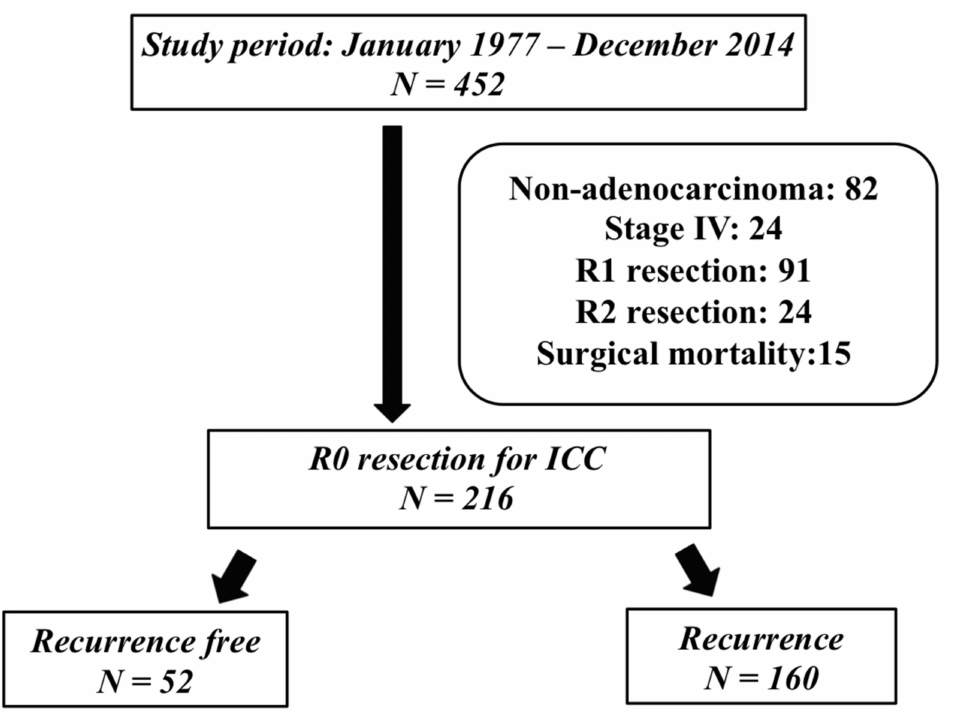
Figure 1. The algorithm and flowchart of patient selection.